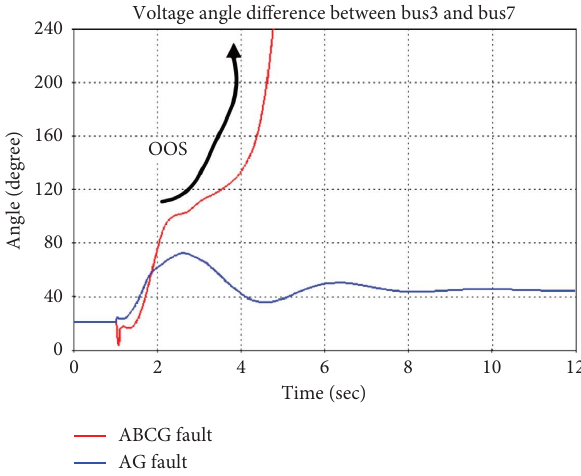
Figure 18: Efect of changing network confguration on voltage angle